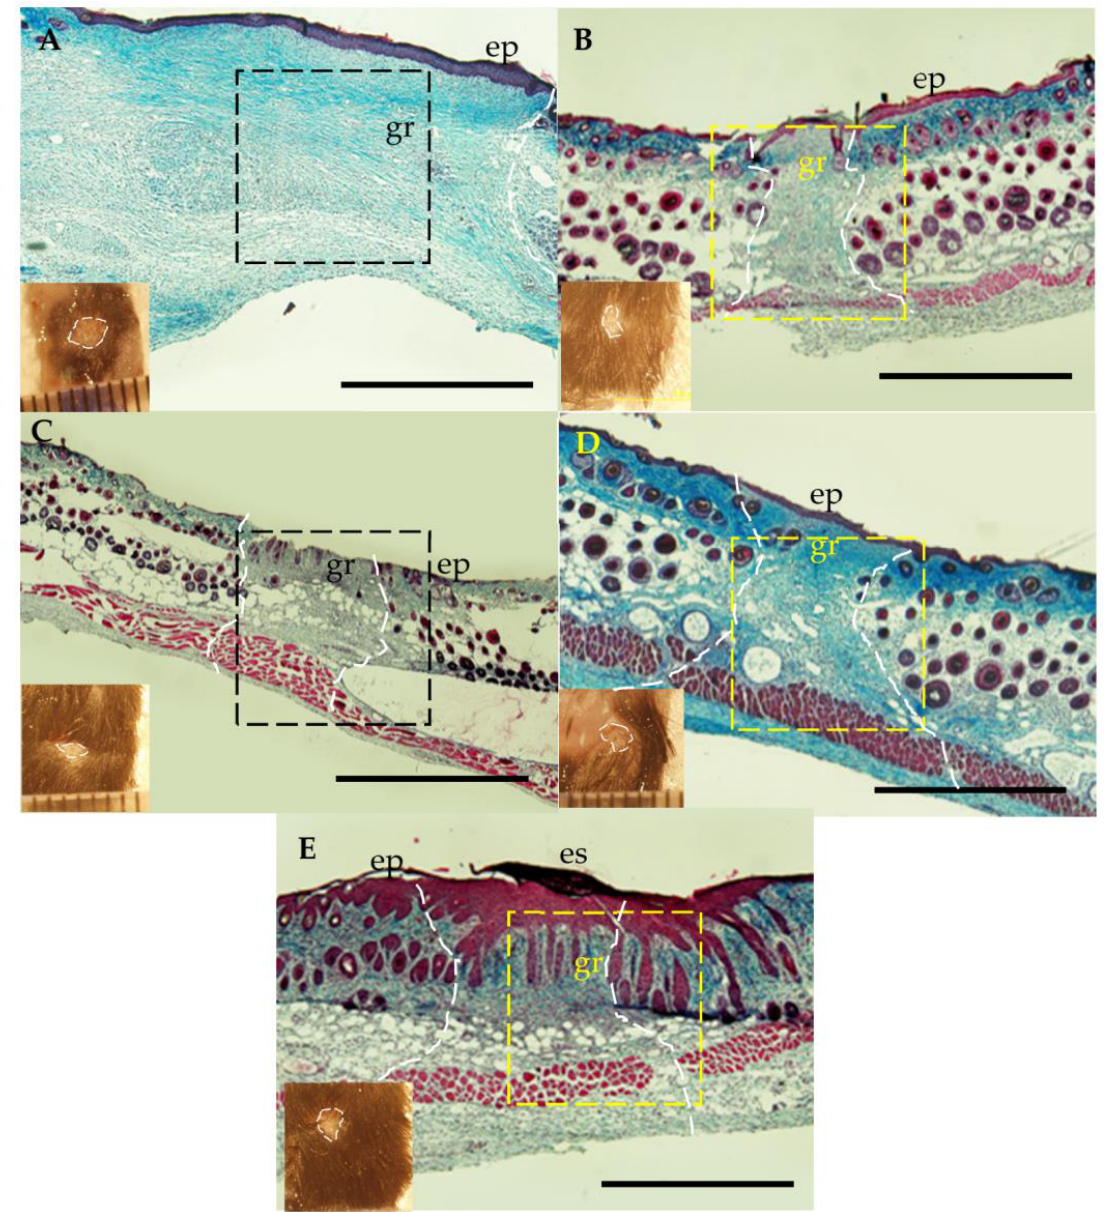
Figure 8. Representative trichrome histological image of the harvested tissue on day 14 after treatment with control ( A ), PEG-D4-Si ( B ), PEG-D6-Si ( C ), PEG-D8-Si ( D ), and PEG-D6 ( E ). Black ( A , C ) and yellow ( B , D , E ) dash lines indicate the area used to calculate collagen content. White dash line indicates the wound proximities. es = eschar, gr = granulation tissue, and ep = epidermis. Scale bars are 1 mm.